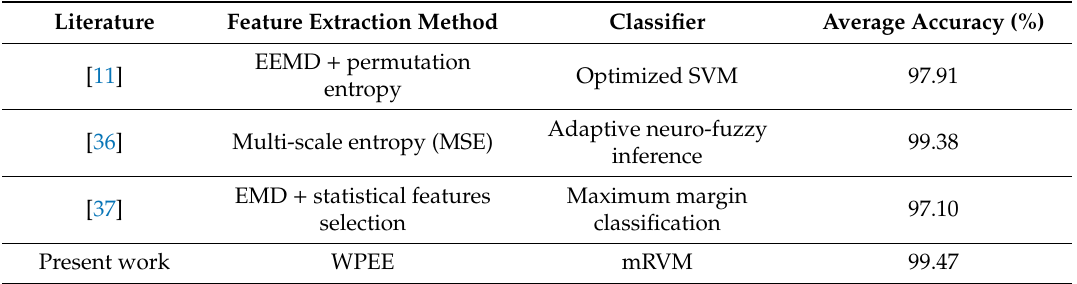
Table 9. Comparative study between the current work and previous works published in the